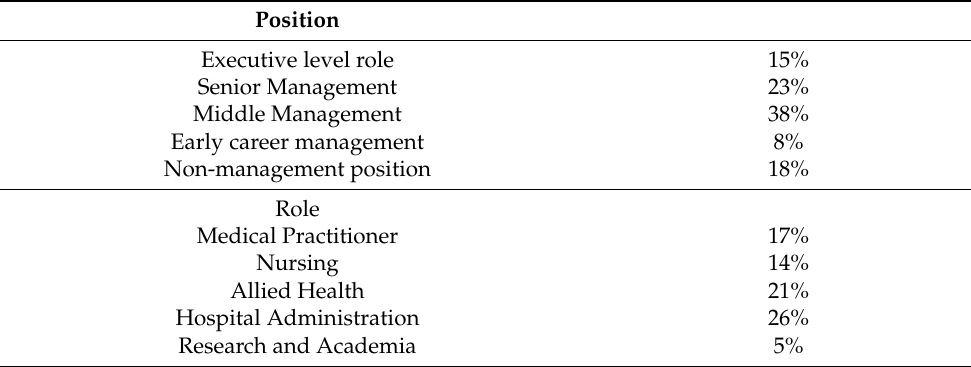
Table 1. Participant demographics in Delphi